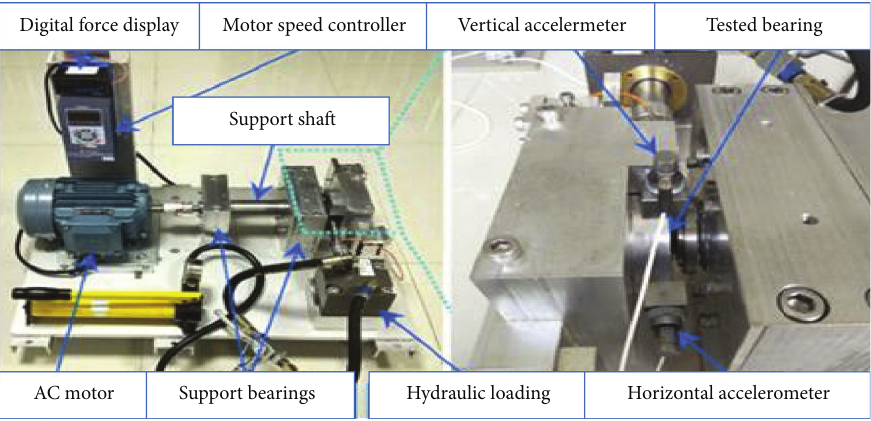
Figure 5: Bearing test rig. Table 1: Bearings’ operation condition.